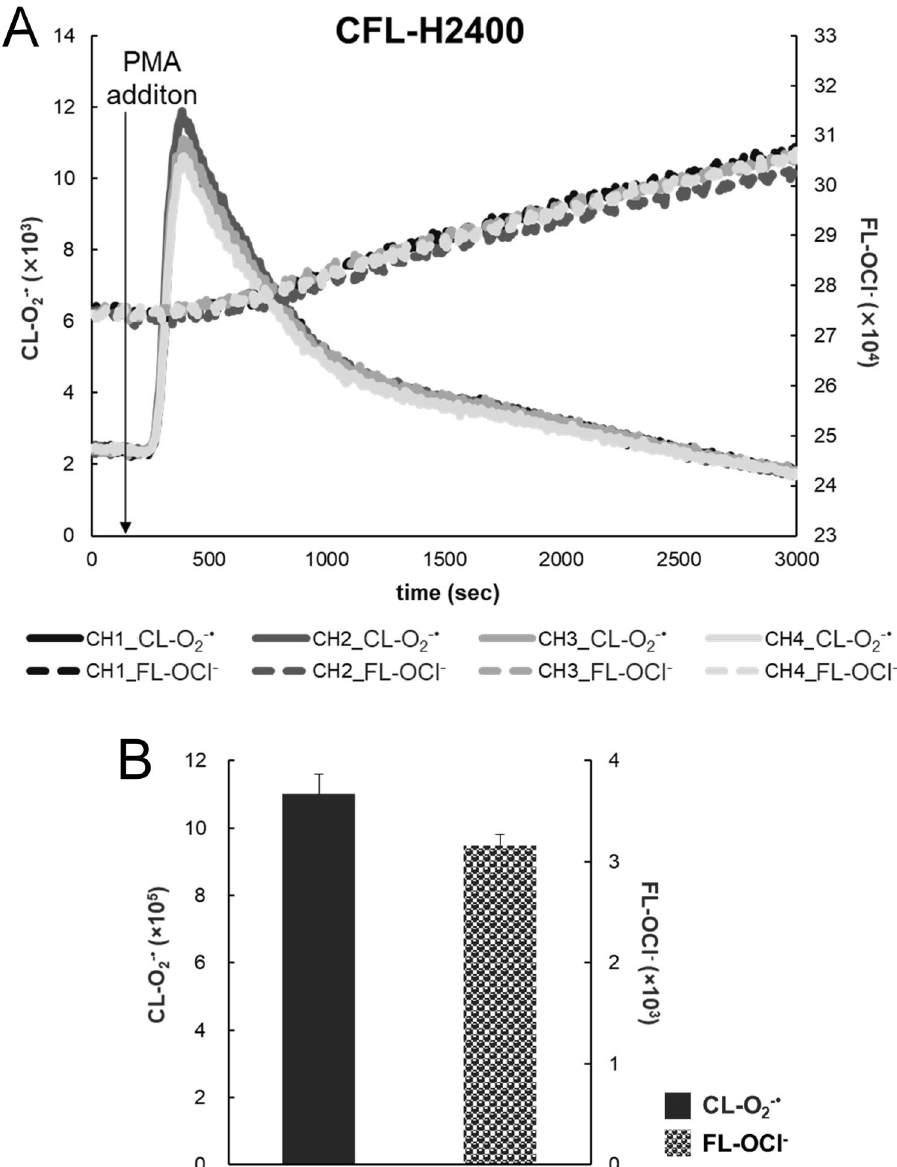
Figure 3. Reproducibility of CL-O 2−· and FL-OCl − measurements in blood. ( A ) Time courses of CL-O 2−· (solid lines) and FL-OCl − (dotted lines) in blood. Four channels of CFL-H2400 were used simultaneously. The left vertical axis shows CL-O 2−· intensity; the right vertical axis, FL-OCl − intensity. PMA was added at 150 s (arrow line). The baseline heights of FL-OCl − were adjusted at the same level. ( B ) Baseline-subtracted total amount of CL-O 2−· and FL-OCl − calculated from the data in ( A ). Error ratios of the four measurements were 2.62% for the total amount of CL-O 2−· and 1.74% for that of FL-OCl −